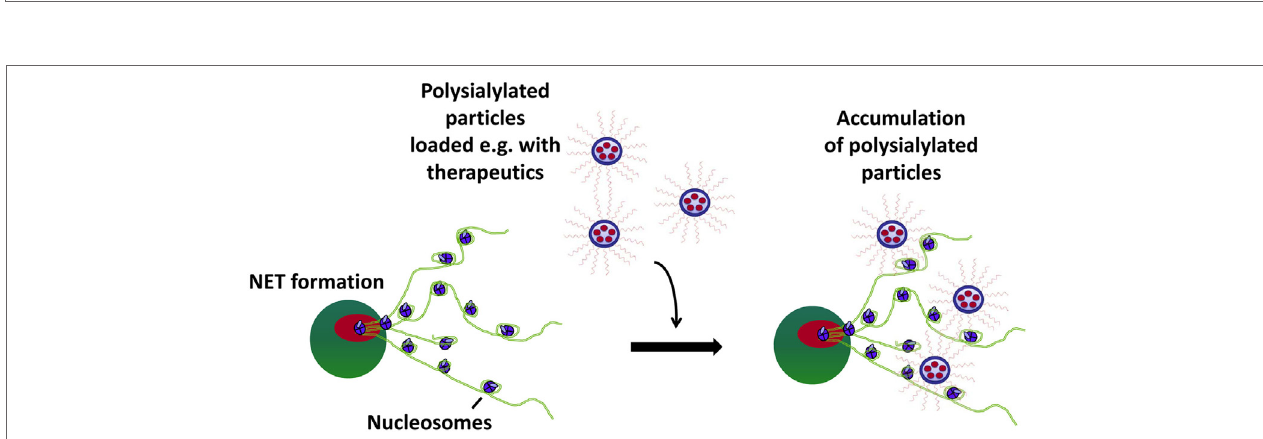
FigUre 5 | Polysialylated nanoparticles accumulate on NET. Polysialylated as well as unpolysialylated fluorescence beads (in red) were incubated with neutrophils after phorbol myristate acetate treatment. (a) 32.5 µg beads/ml; (B) 325 µg beads/ml. NET was visualized by DAPI and an antibody against neutrophil elastase. Scale bar: 100